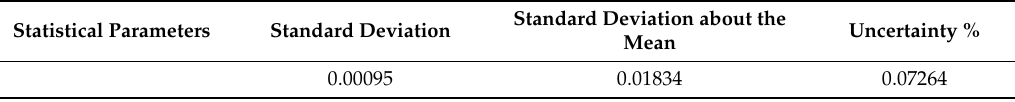
Table 3. Uncertainty associated with Ultrasonic Ranging System (URS)